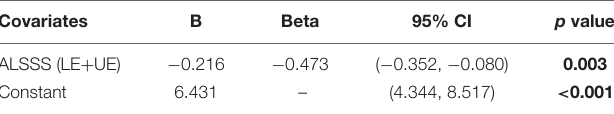
TABLE 3 | Factors associated with the presence of pain in the binary logistic analysis. Covariates